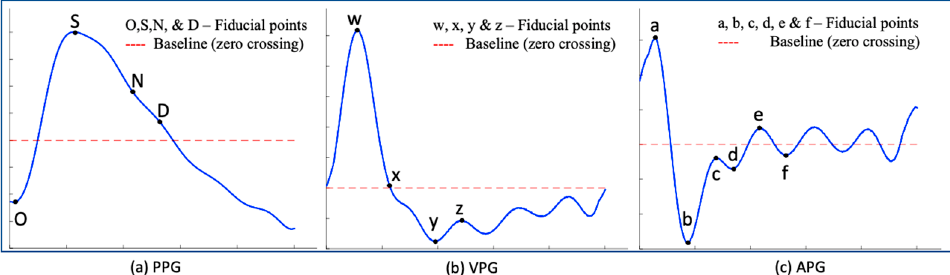
Figure 1. Illustration of fiducial points, where the blue lines in ( a ) represent the PPG waveform, ( b ) represent the VPG waveform, and ( c ) represent the APG waveform.